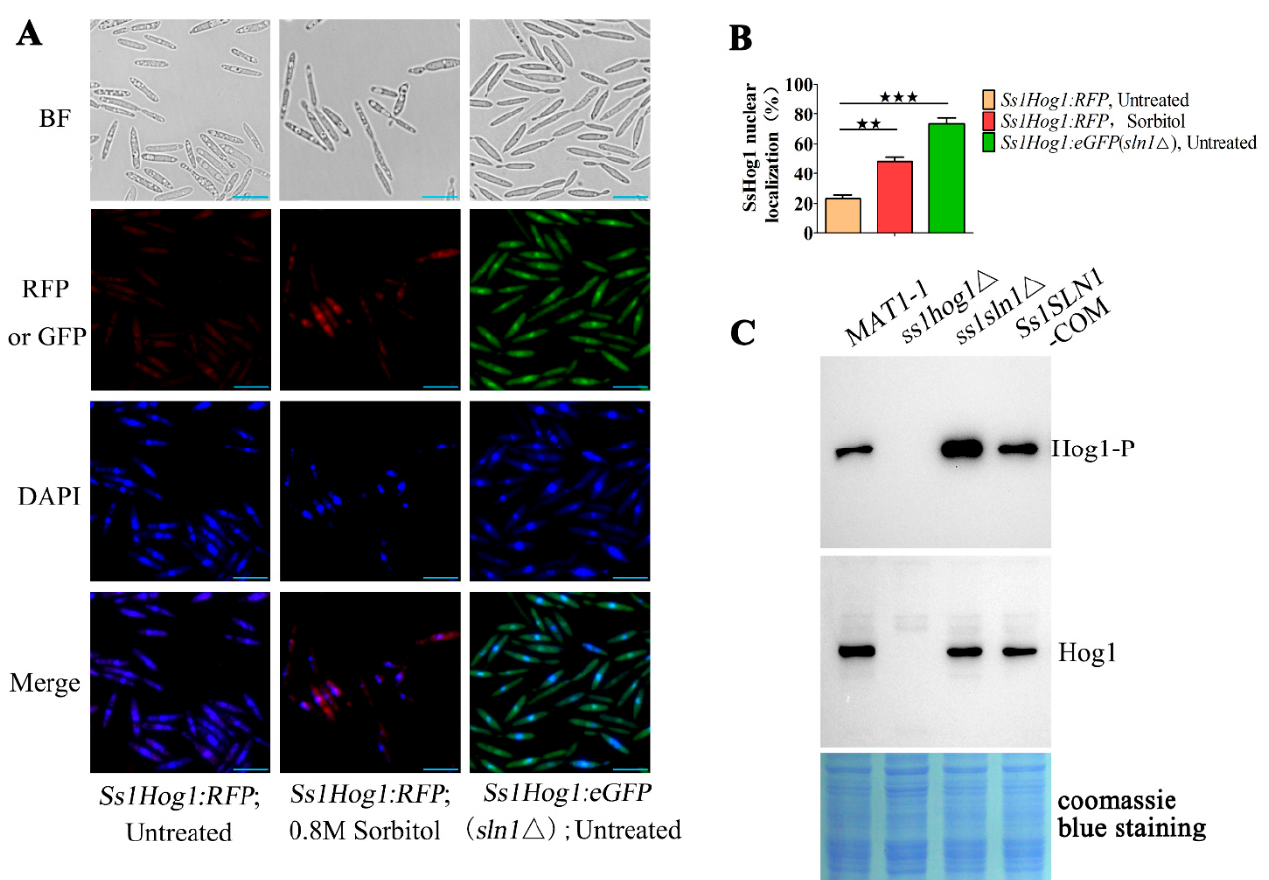
Figure 3. Effect of SsSln1 on phosphorylation and subcellular localization of SsHog1. ( A ) Subcellular localization of SsHog1 protein in S. scitamineum . The Ss1Hog1:RFP and Ss1Hog1:eGFP ( sln1 ∆ ) sporidia were grown up to O.D.600 = 1.0, and then treated with or without 0.8 M sorbitol in YePSA medium at 28 ◦ C for 60 min. The nucleus was stained with DAPI and the images were taken under fluorescence microscope. Scale bar = 10 µ m. ( B ) Bar chart depicts the quantification of nuclear localization as shown in ( A ). Percentage (%) of nuclear localization cells/total cells is indicated. Bar chart depicts (cid:70)(cid:70) p (cid:70)(cid:70)(cid:70) p the statistical difference among the mean values ( < 0.01, < 0.001). Mean ± S.E. were derived from three independent biological repeats with three replications. ( C ) Phosphorylation of SsHog1 was enhanced in ss1sln1 ∆ mutant cells. The fresh haploid sporidia were grown in YePSA medium at 28 ◦ C for 30 h. The total protein of sporidia was extracted with lysis buffer. Western blots depicting the levels of SsHog1 phosphorylation in the indicated strains. Above: blots were probed for phosphorylated SsHog1 (Hog1-P). Below: blots were probed for total SsHog1 (Hog1). Coomassie blue staining of total proteins served as loading